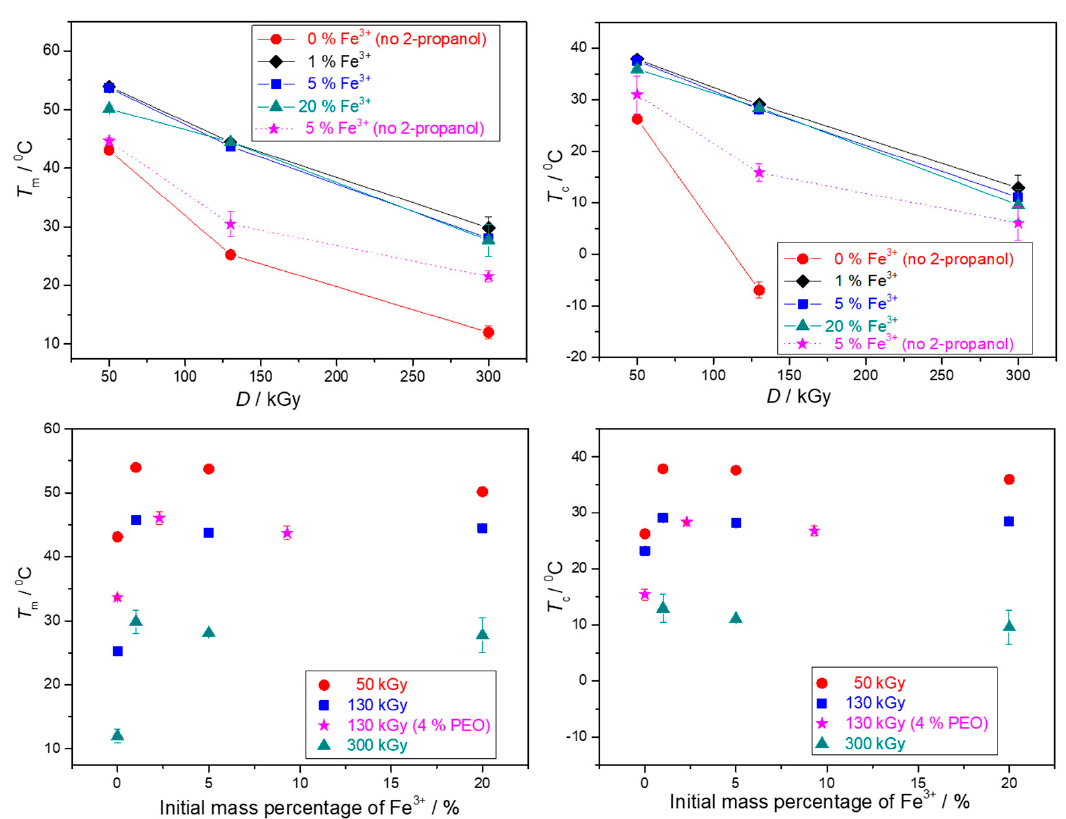
Figure 11. Melting ( T m ) and crystallization ( T c ) temperatures of the 2nd heating cycles and 1st cooling cycles, respectively, of the obtained gels in dependence on the irradiation dose and the mass percentage of Fe 3 + in precursor suspensions. Unless otherwise indicated, the precursor suspensions were prepared from 1.85 wt% PEO solutions and with 0.2 M 2-propanol.